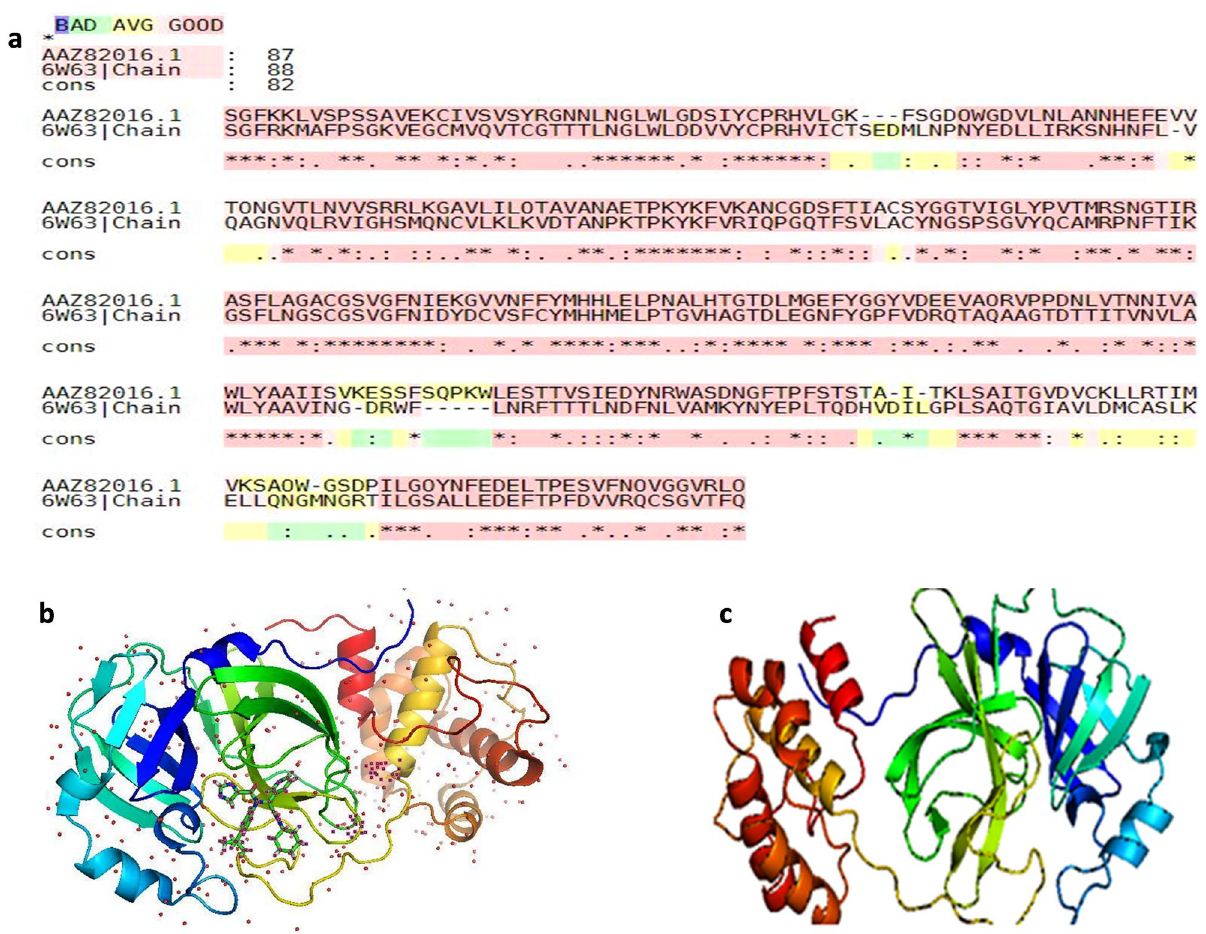
Figure 2. Sequence alignments between 3CLpro of SARS-CoV-2 and avian infectious bronchitis virus: ( a ) result of M-Coffee server, ( b ) 3D structure of SARS-CoV-2 3CLpro, and ( c ) 3D structure of avian infectious bronchitis virus 3CLpro.